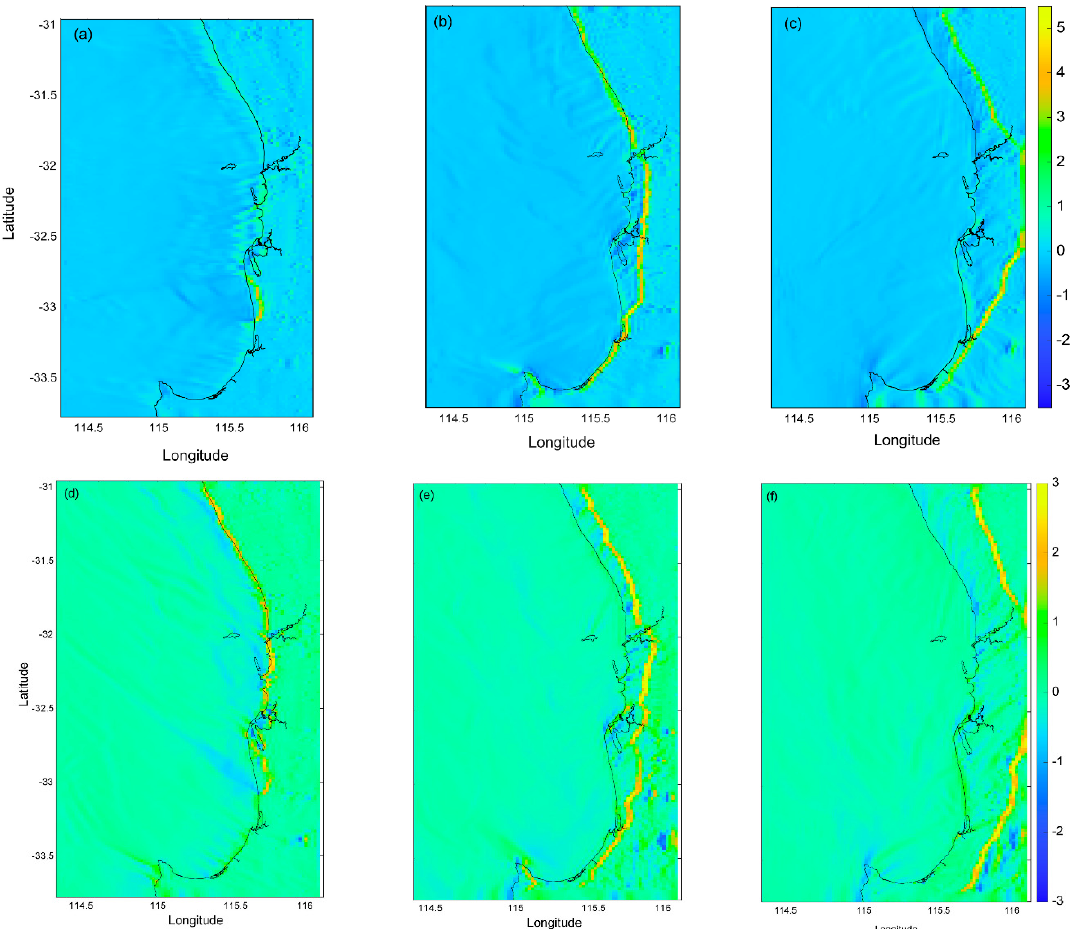
Figure 10. Divergence of the wind vector: ( a ) 0900; ( b ) 1200; and, ( c ) 1500 for 8 December 2016 (same as that for Figure 8); and, ( d ) 0900; ( e ) 1200; and ( f ) 1500 for 23 February 2017 (same as that for Figure 9). Units of divergence are s − 1 . Note different scales for the different days.